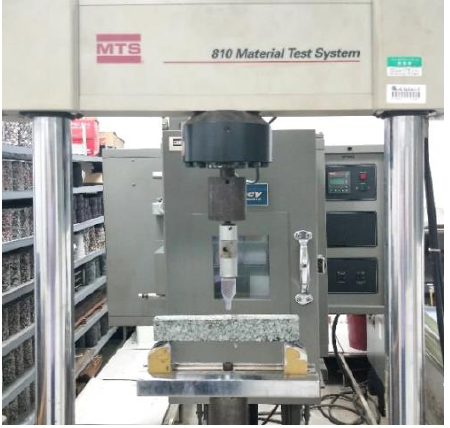
Figure 4. Three-point bending test device for the epoxy asphalt mixture beams.